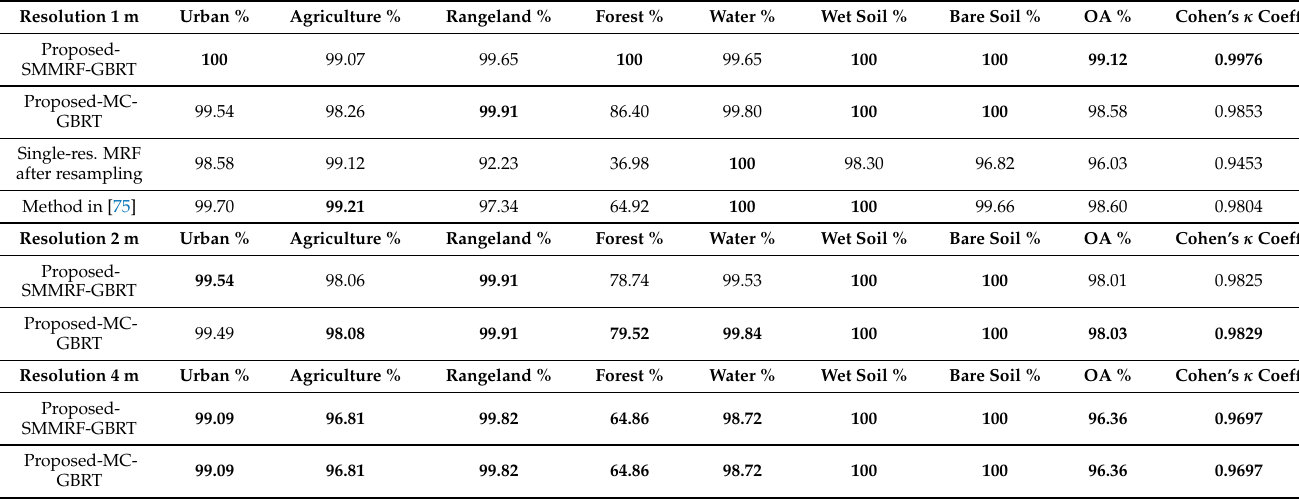
Table 4. “Alessandria” dataset: class-wise accuracies of the proposed algorithms, applied with GBRT and compared with benchmark methods, with respect to the test set.